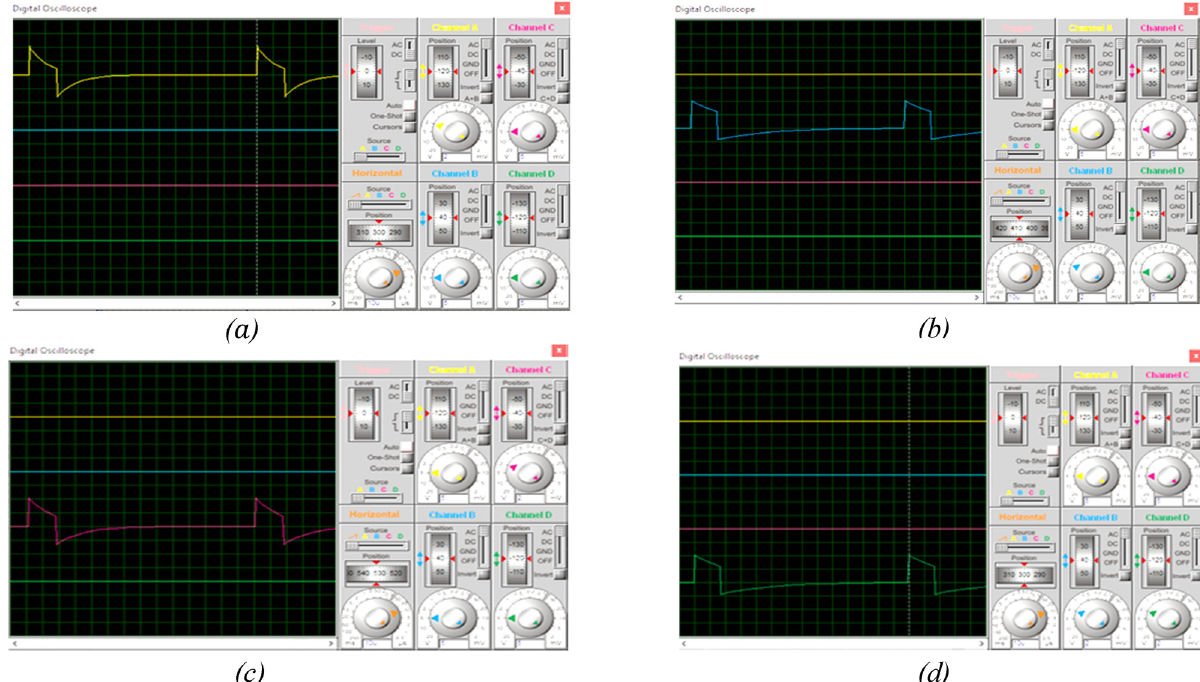
Figure 6: PD signals due to the e ff ect of the calibrating capacitors ( cylindrical ) . ( a ) PD signal with respect to C 1 . ( b ) PD signal with respect to C ( c ) PD signal with respect to C 2 .